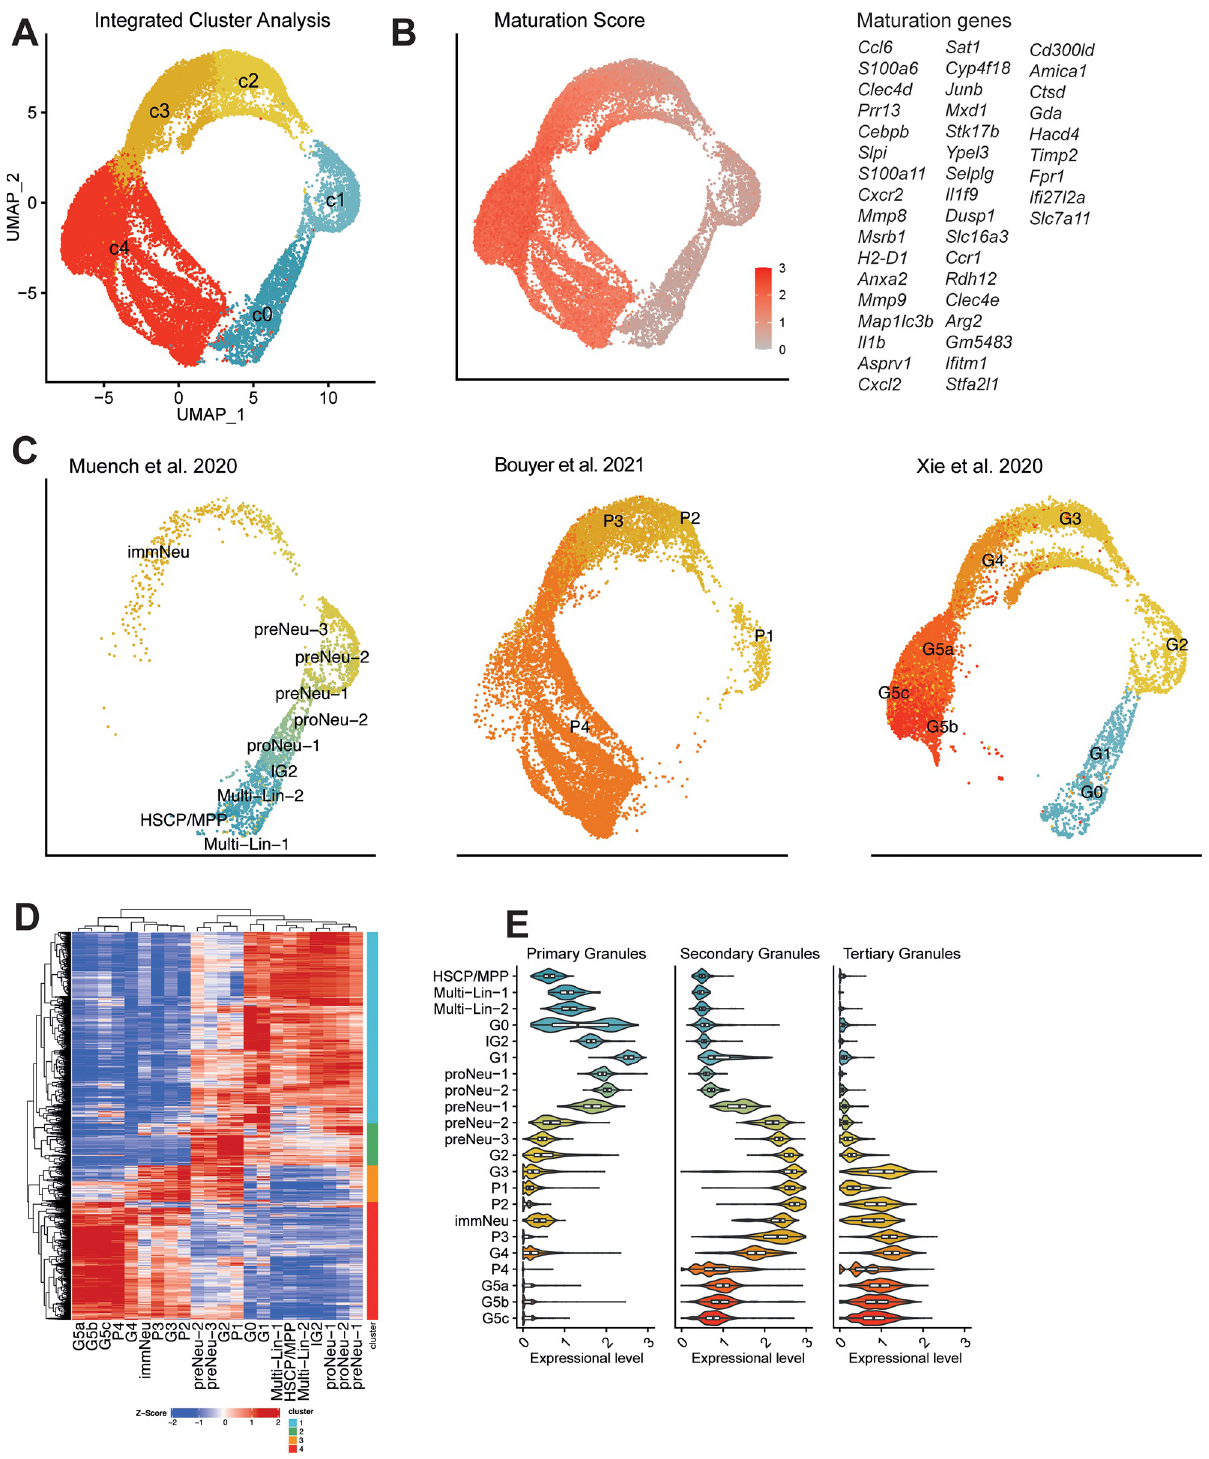
Fig 1. Integrated scRNA-seq analysis of mouse neutrophils under differentiation. (A) The Uniform Manifold Approximation and Projection (UMAP) presentation of 4 major cell clusters in mouse neutrophils from bone marrow and blood. (B) The UMAP map showing the maturation score of neutrophils from bone marrow and blood. (C) The UMAP presentation of cell clusters divided by the study of scRNA-seq neutrophils. (D) Unsupervised hierarchical clustering of all differentially expressed genes (|log2(fold change| > 1) and padj < 0.01), based on Manhattan distances using the Ward method. Data are presented as heatmap normalised to the minimum and maximum of each row. (E) Violin plot of maturation scores for neutrophil primary, secondary and tertiary granules in each scRNA-seq-defined cluster. https://doi.org/10.1371/journal.pone.0276460.g001 PLOS ONE | https://doi.org/10.1371/journal.pone.0276460 October 21,